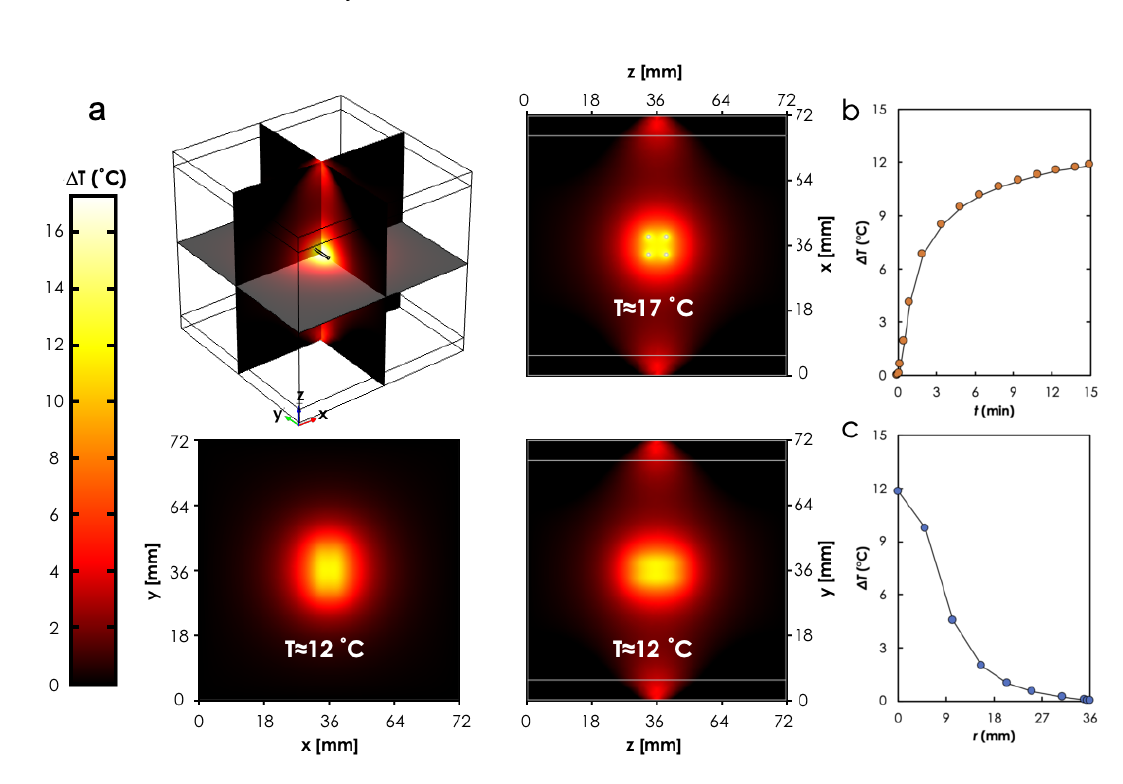
Figure 6. FEM simulation results. ( a ) Predicted temperature distributions for different cross-sectional views of the geometry. Temperature change as a function of ( b ) time at and ( c ) distance away from point P1. Study parameters: P 0 = 1.0 W, t = 15